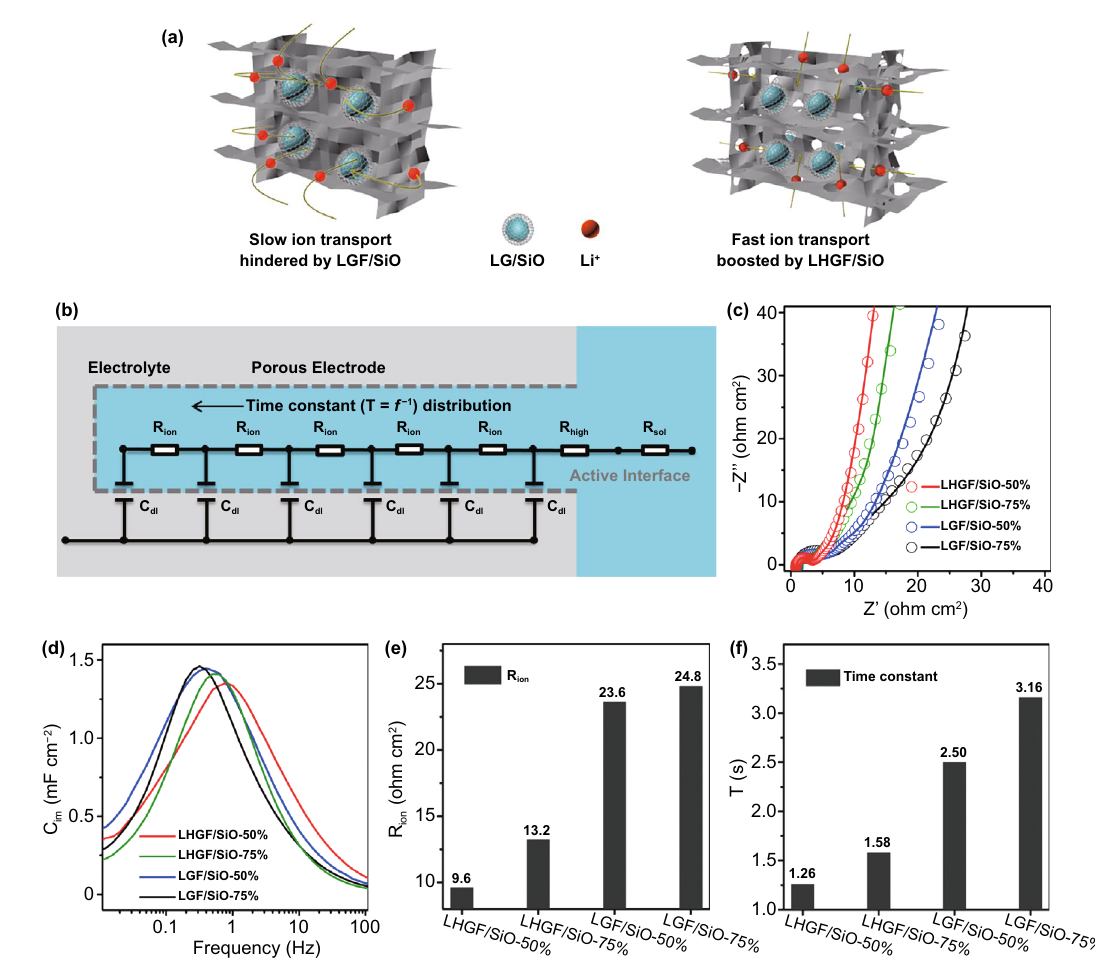
Fig. 2 Evolution of kinetic properties and electrochemical characteristics with porosity. a Li + transport schematic diagram of LHGF/SiO and LGF/SiO electrode. b Schematic representations of porous electrode structure and the equivalent circuit models Non-faradaic process at unlithi- ated state. c Nyquist plots for composites by using a symmetric cell with two identical electrodes (11 mg cm −2 ). The symbols and solid lines represent the experimental and simulation results, respectively. d The imaginary part of capacitance as a function of the frequency for various composite electrodes at a mass loading of 11 mg cm −2 . e The ionic resistance ( R ion ) of different composite electrodes. f The time constant (T) as a function of different composite